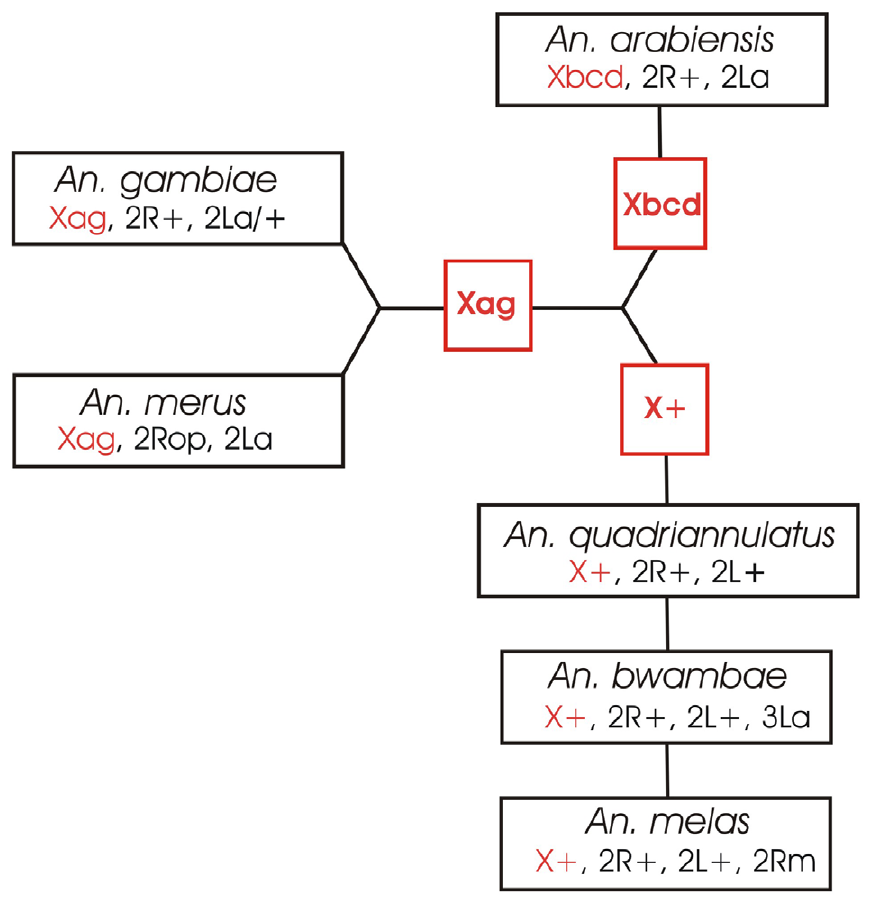
Figure 1. The three species clades identified based on the X chromosome fixed inversions in the An.gambiae complex. The X chromosome arrangements are shown in red.